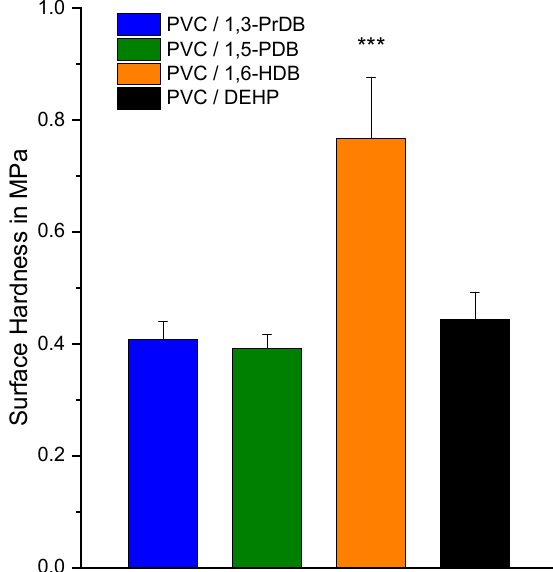
Figure 6. Surface hardness of 40 phr blends of PVC with 1,3-PrDB, 1,5-PDB, 1,6-HDB, and DEHP, as determined by nano-indentation. Standard deviation is shown with n = 3 for each of the diol dibenzoate compounds and n = 5 for DEHP. Results for 1,6-HDB were statistically significantly different than those of blends of all other compounds ( p < 0.001).